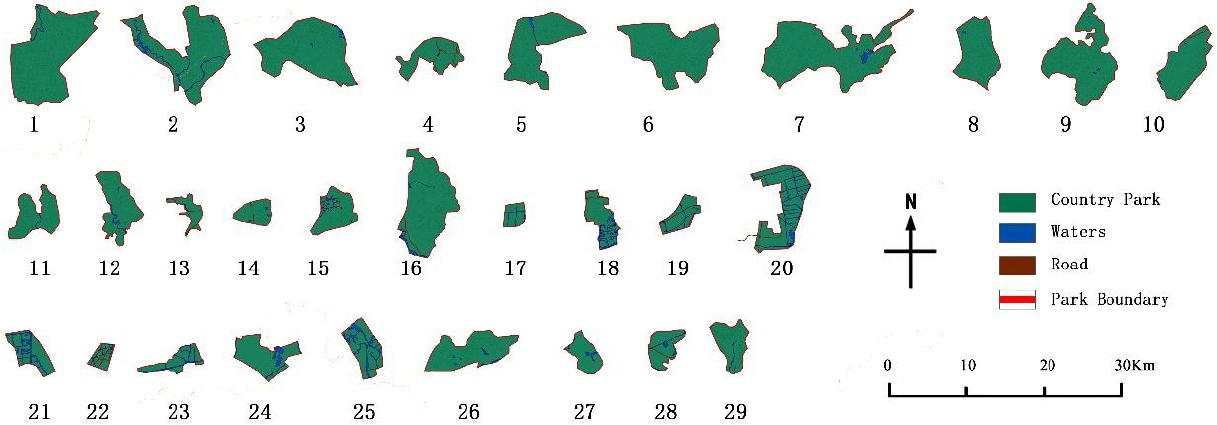
Figure 6. The spatial fragmentation of country parks. Table 11. The results of water source protection area of country